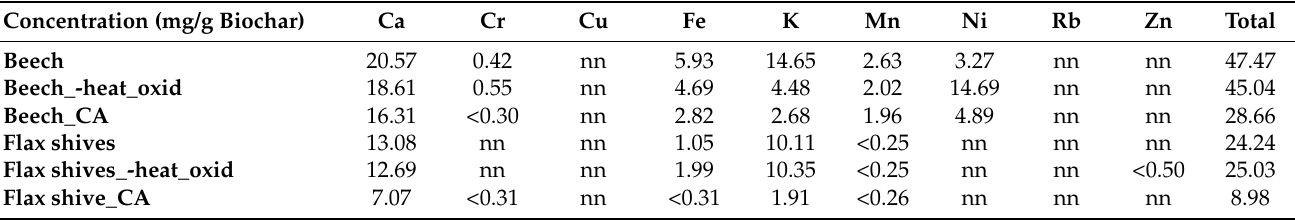
Table 4. ICP analysis results for different used biochars, before and after